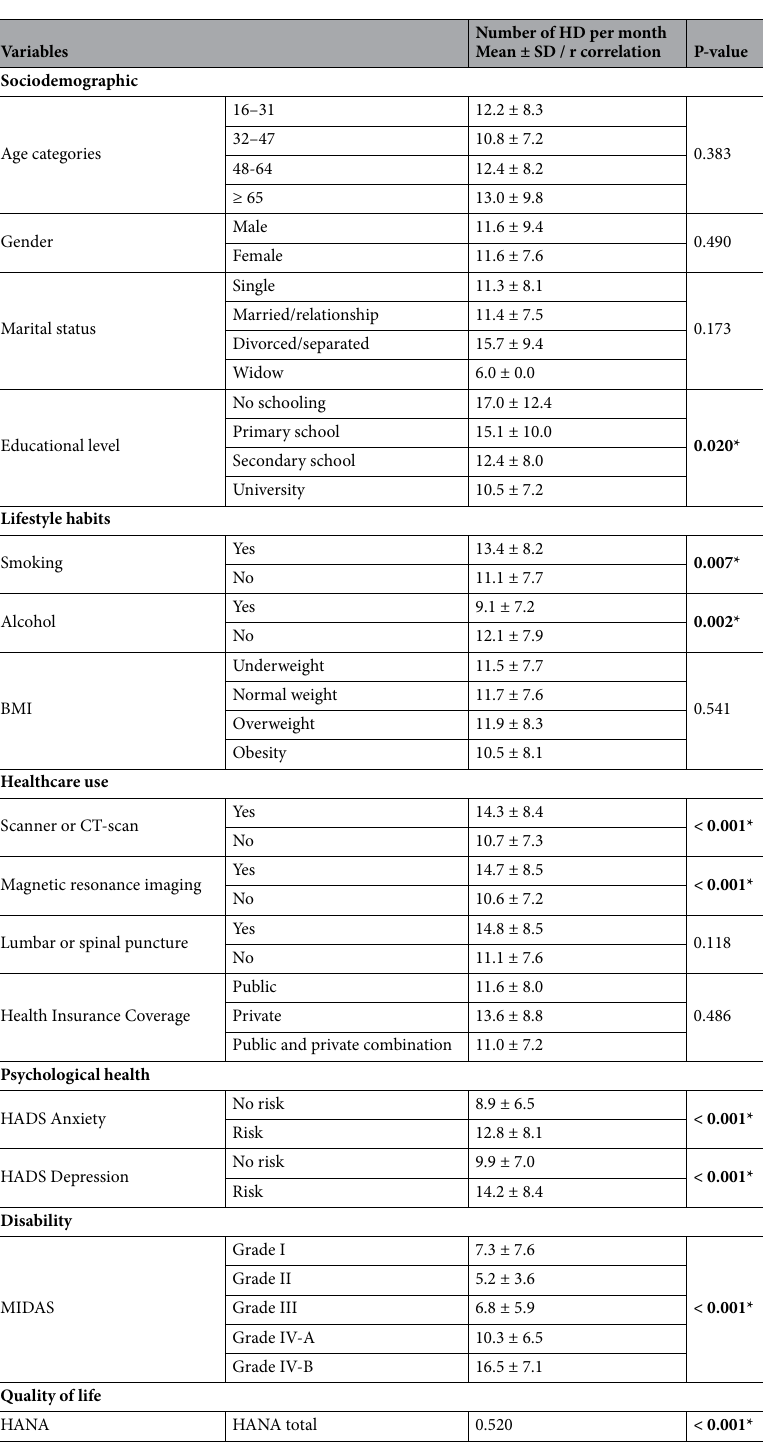
Table 2. Bivariate analysis between the number of HD per month and sociodemographic, life habits, healthcare utilization, mental health and disability. PRO patient-reported outcome; HADS hospital anxiety and depression scale; HANA headache needs assessment; MIDAS migraine disability assessment scale; LFEM (Low-frequency episodic migraine); MFEM (Medium-frequency episodic migraine); HFEM (High-frequency episodic migraine); CM (Chronic